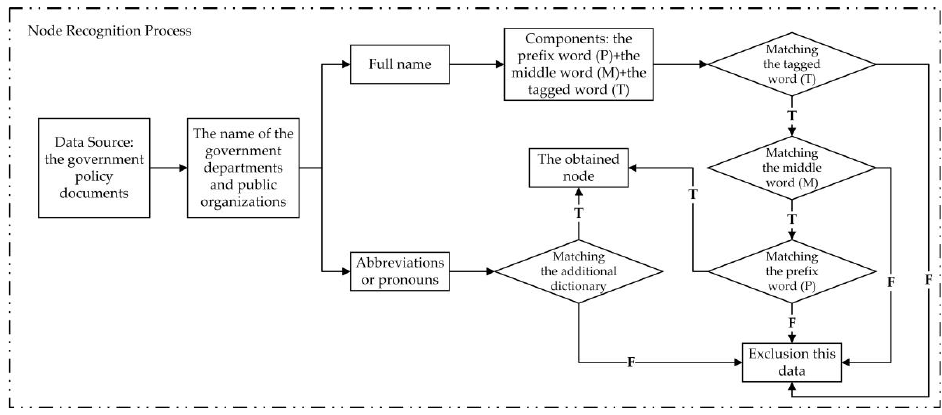
Figure 2. The node recognition process.